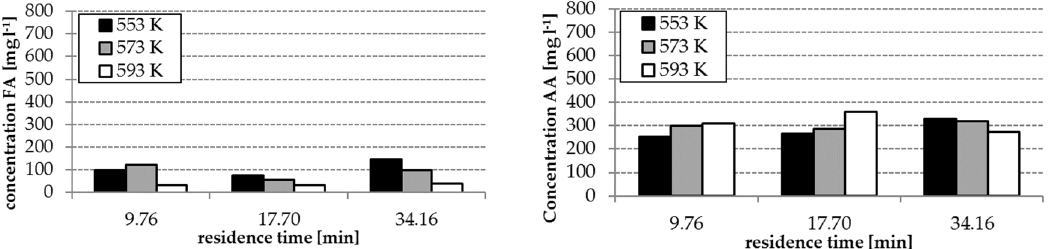
Figure 3. Concentrations of formic acid (FA) and acetic acid (AA) after hydrothermal treatment of grass suspensions without a catalyst (CTR, 1% w / w grass powder suspended in water; residence time: 9.76–34.16 min, reaction temperature: 553–593 K).